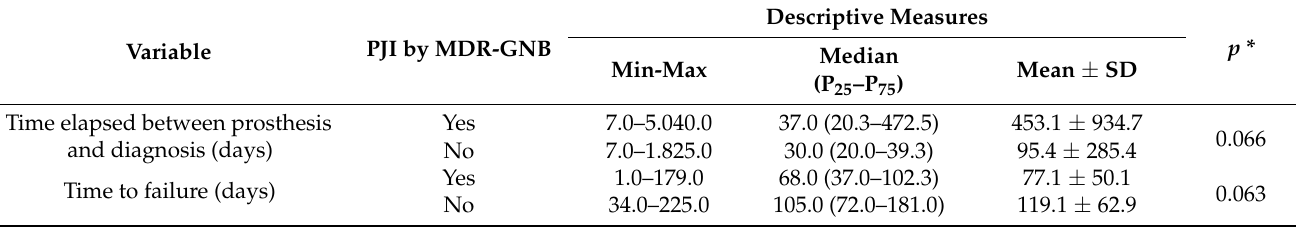
Table A2. Comparative analysis between the two study groups regarding the time elapsed between prosthesis and diagnosis and time to therapeutic failure.